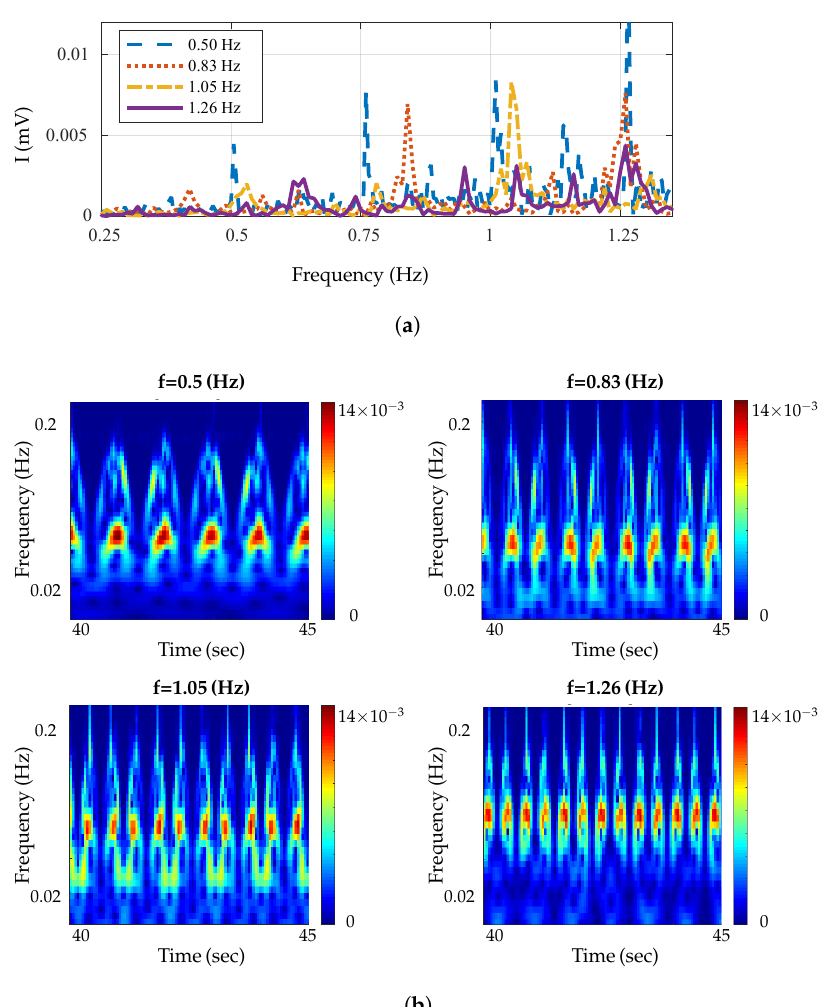
Figure 2. Baseband signals reflected from the metronome. ( a ) Spectrum of baseband signals at various frequencies. ( b ) Wavelet magnitude scalograms of baseband signals for metronome at various